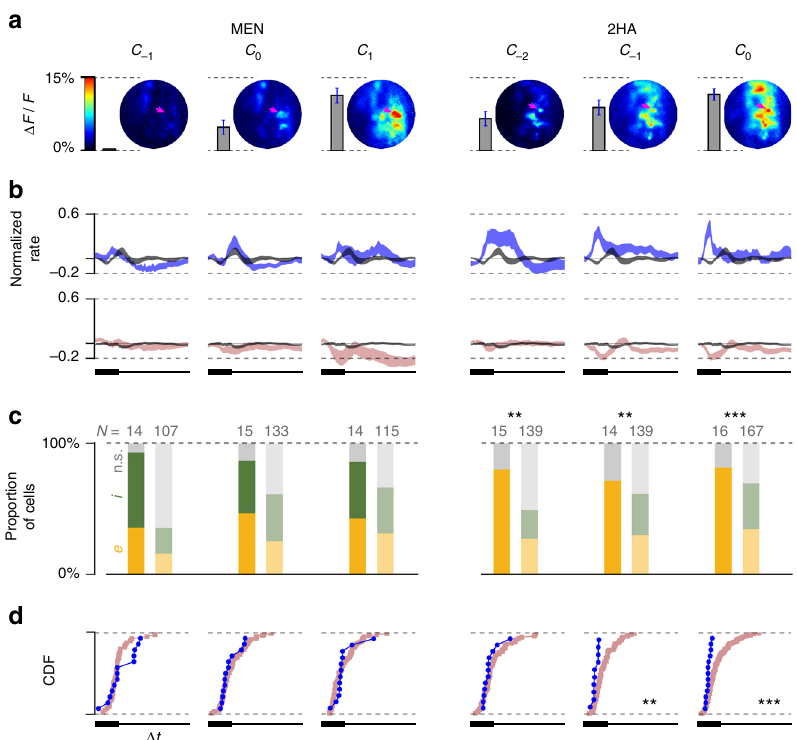
Fig. 5 Robustness of population diversity/stereotypy across odor concentrations. Panels as in Fig. 4. a Map of Ca 2 + activity for each odor, and vertical bars indicating the average level of M72 glomerulus activation. Left three columns show increasing concentrations of MEN, a weak ligand for M72-OSNs. Right three columns show increasing concentrations of 2HA, a strong ligand for M72-OSNs. C 0 denotes concentrations equivalent to stimuli presented in Fig. 4; C − C − C C C C 2 , 1 , and 1 denote concentrations of 0.01 0 , 0.1 0 , and 10 0 , respectively. (Note: due to differences in the experimental setups, in imaging experiments the concentrations for MEN were 1.8× lower than the corresponding concentrations in electrophysiological experiments, and 2× higher for 2HA.) b Mean snif fl et responses for M72-MT (blue) and other (pink) populations. c Distribution of the polarities of the fi rst signi fi cant responses for M72 (left bar; bold) and other (right bar; desaturated) MT cells. d CDFs of the latency to fi rst signi fi cant